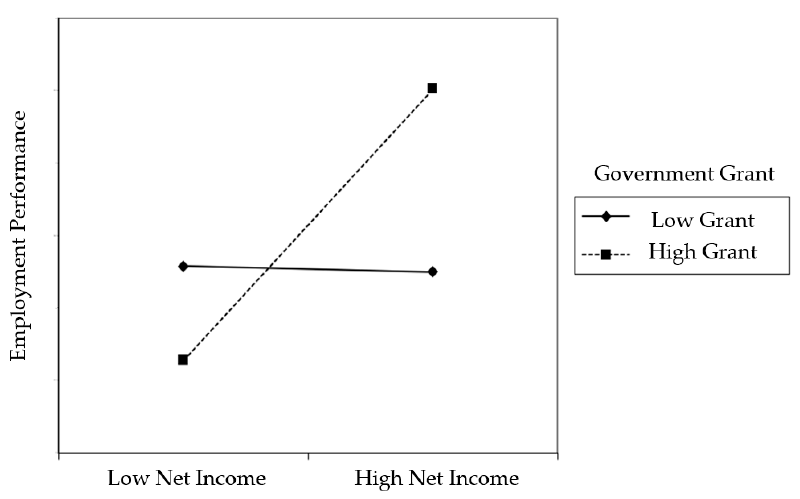
Figure 1. Moderation e ff ect of government Figure 2. Moderation effect of government grants. Table 4. Panel analysis: salary level, employment performance and return on assets (ROA).